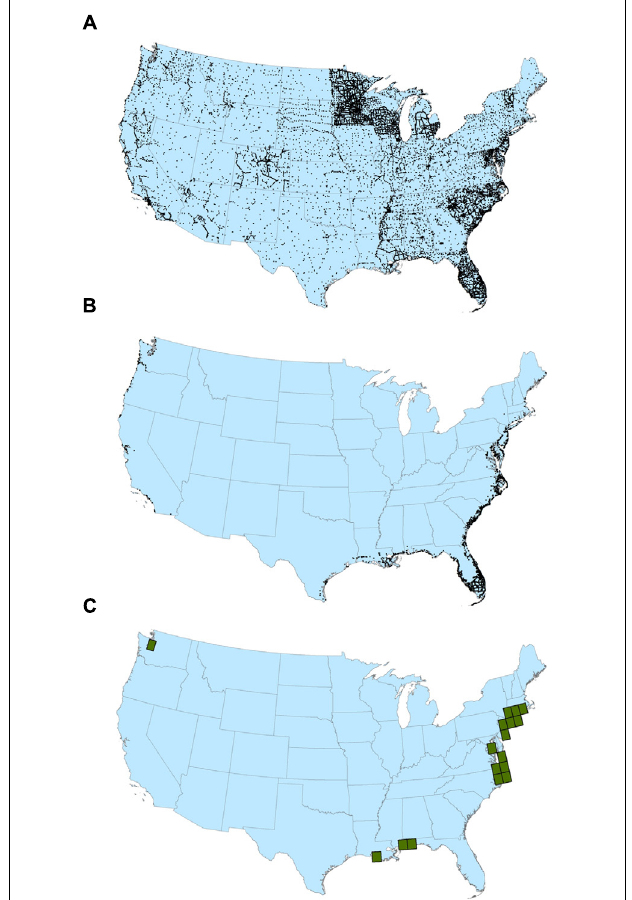
FIGURE 1 | (A) : GPS on Bench Marks reference data for CONUS (23,115 points); (B) : Subset of reference data in the low elevation coastal zone (3,480 points); (C) : Test area of 17 one-degree by one-degree tiles for direct DEM